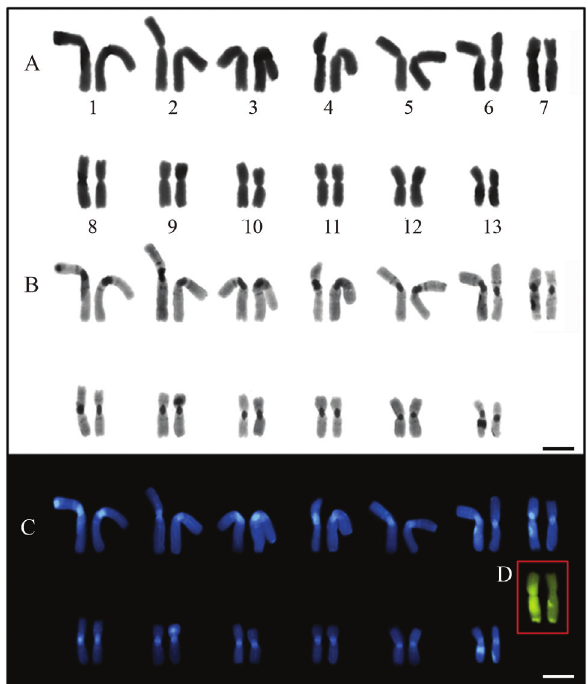
Figure 1 - Sequential karyotypes of a male specimen of Bolitoglossa paraensis : A) conventional Giemsa staining, B) C-banding pattern, C) DAPI staining; D) NOR CMA 3 + staining. Bar = 10 (cid:2) m.